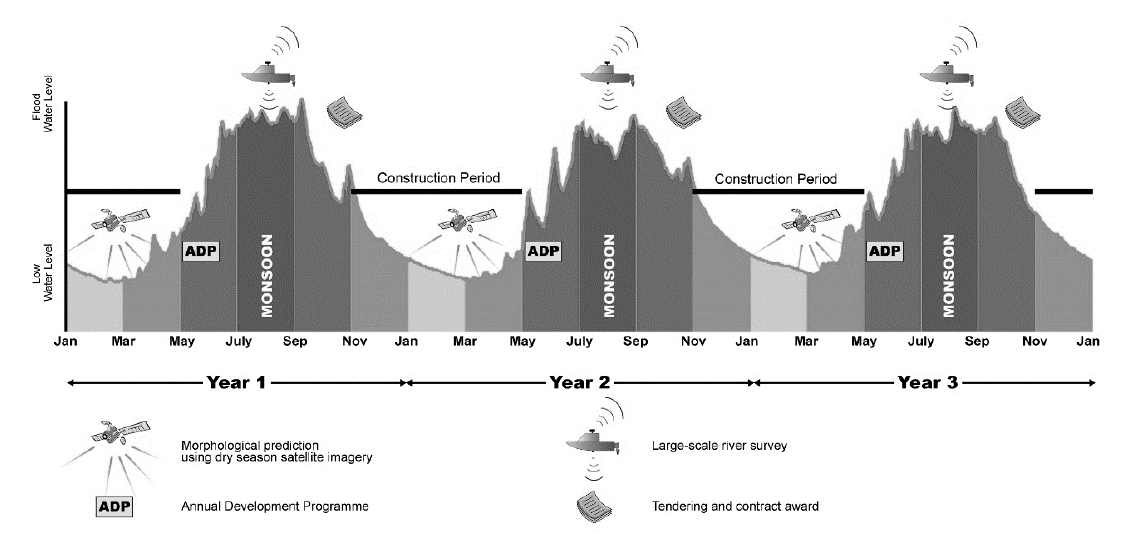
Figure 9. Elements of a broad design development process [49].